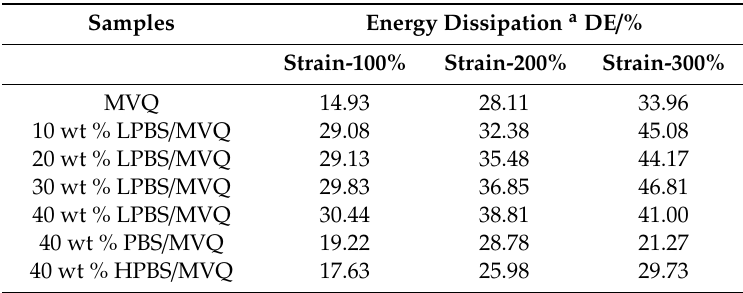
Table 3. Dissipation coe ffi cient of PBS / MVQ rubber composites